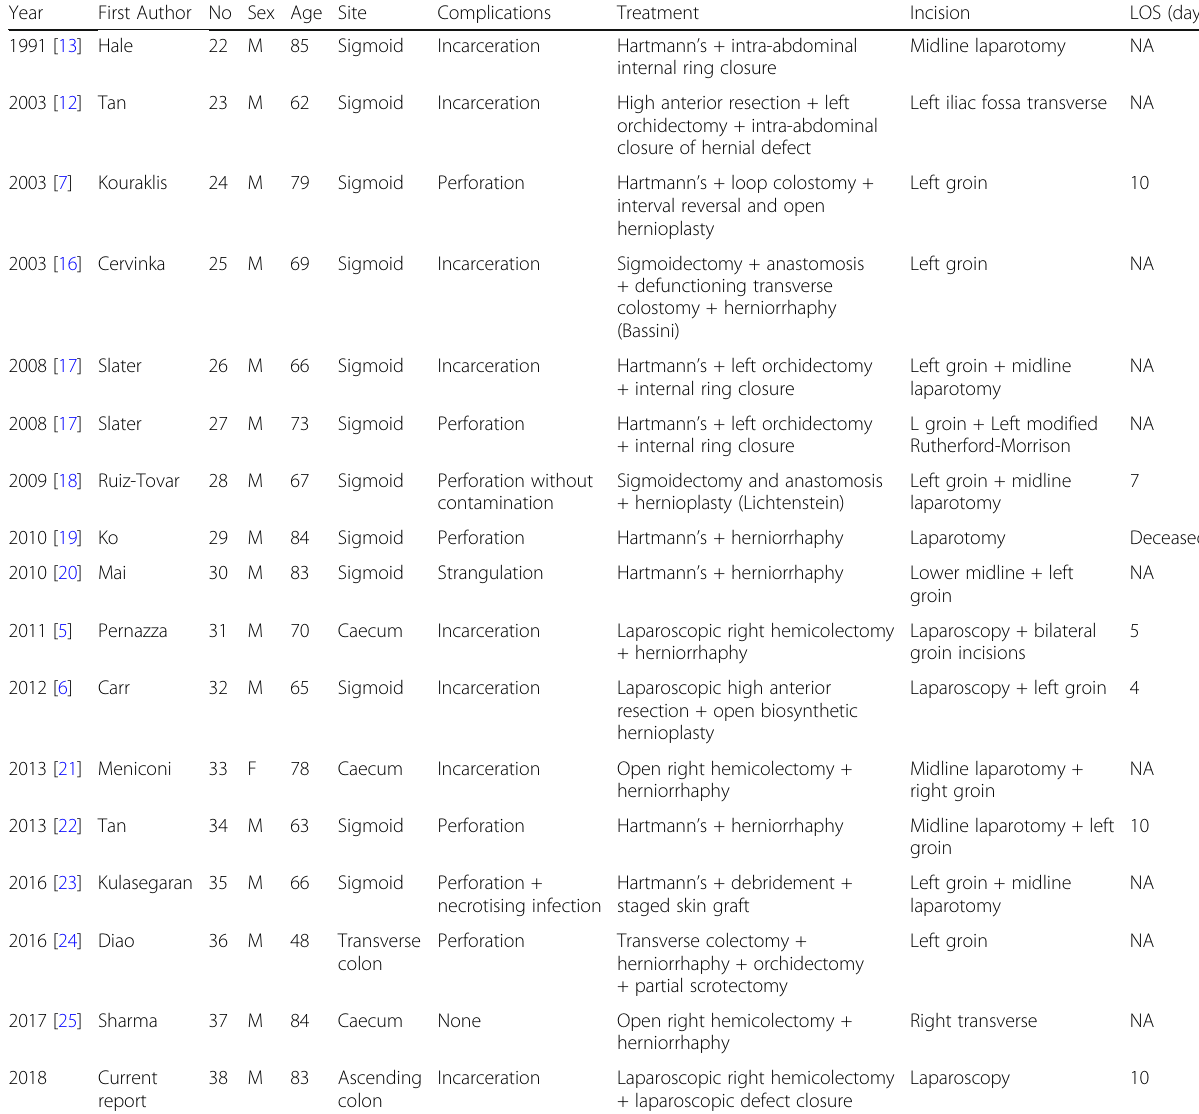
Table 2 Cases of bowel cancer presenting within inguinal hernias in the last 30 years